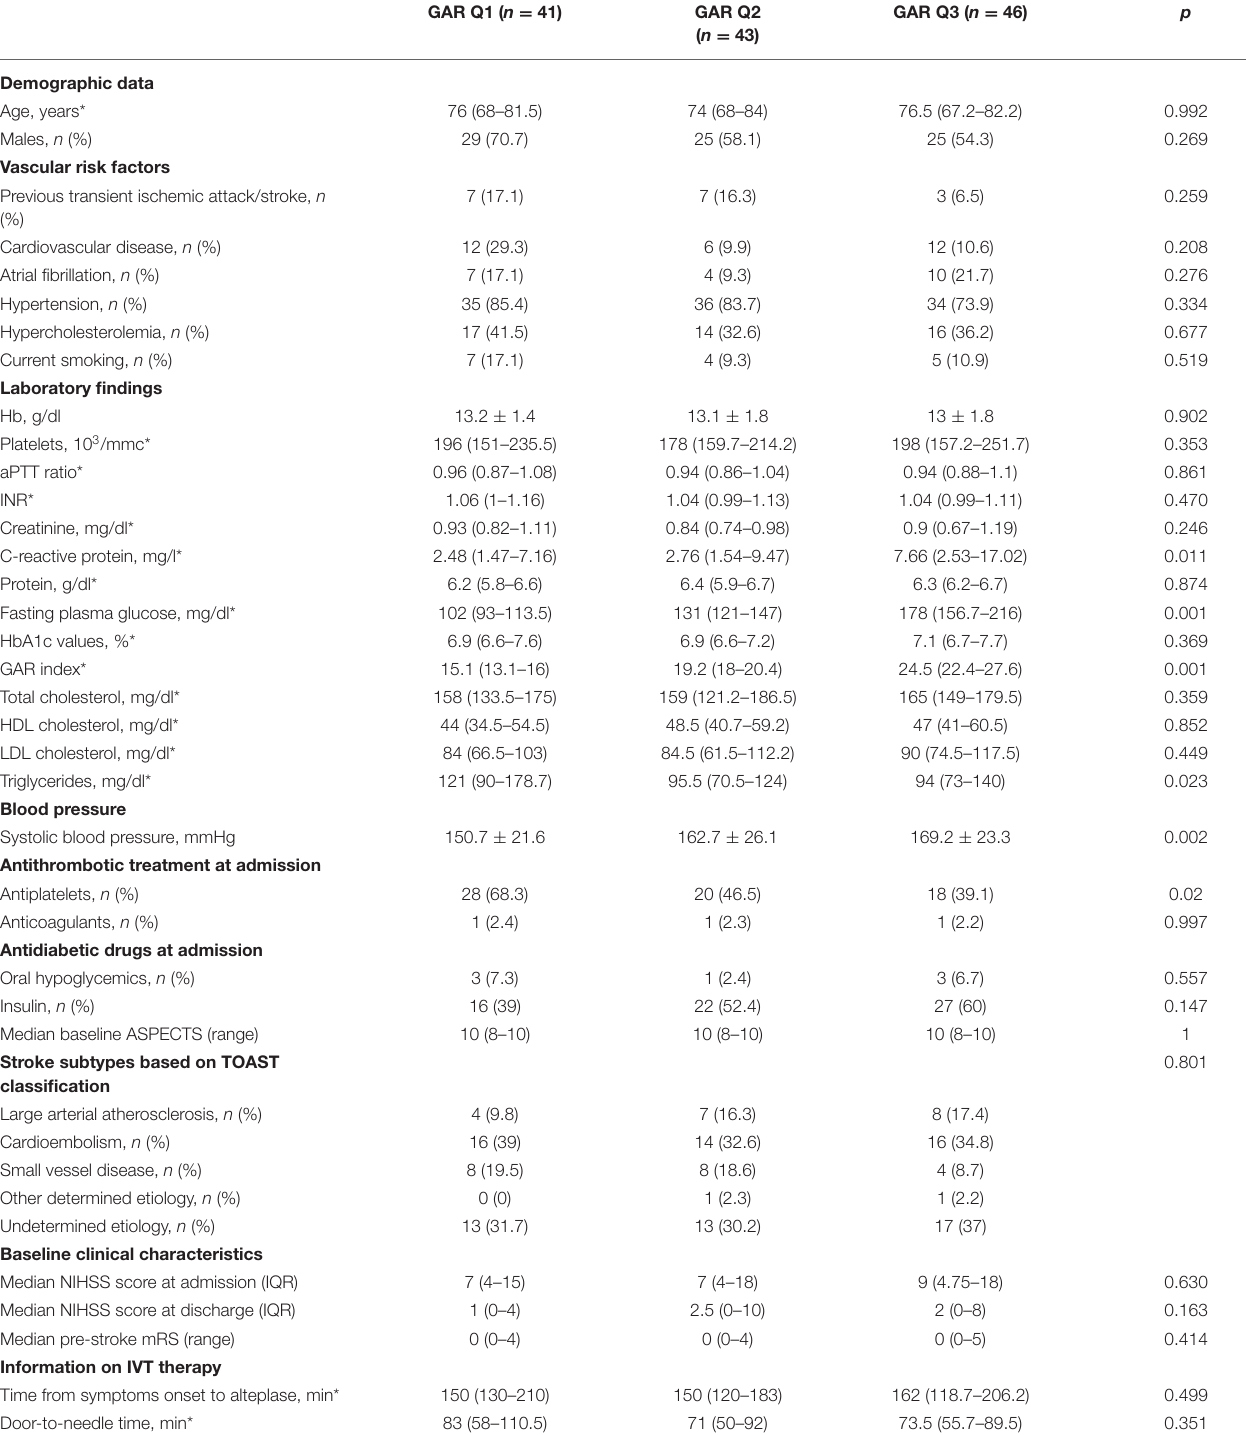
TABLE 1 | General characteristics of 130 diabetic patients according to the GAR